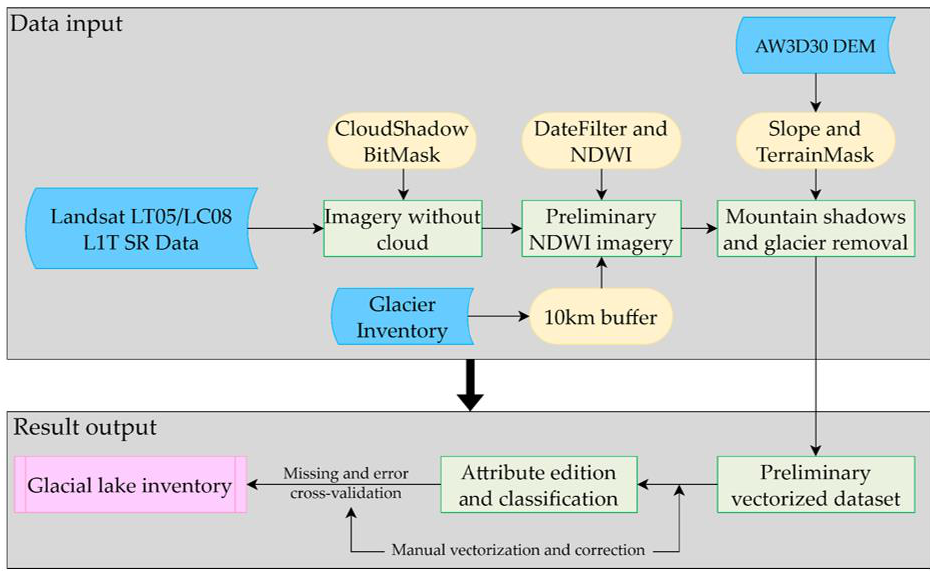
Figure 2. Flowchart of the glacial lake automatic extraction and mapping workflow.